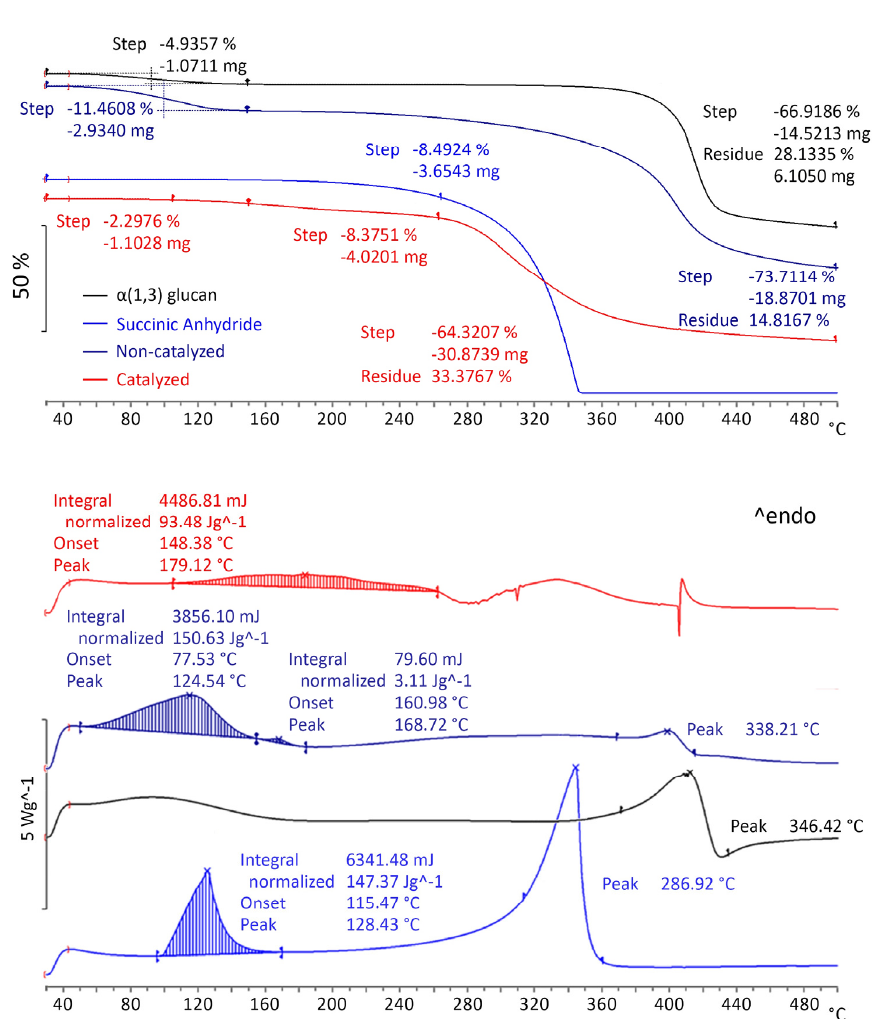
Figure 5. Coupled TGA/DSC runs on products derived from the modification of α -(1,3) glucan with SA in micro scale.